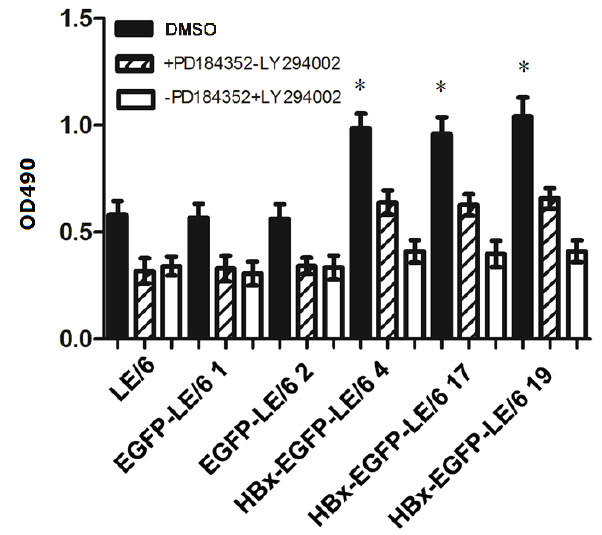
Figure 5. MTT assay of HBx-EGFP-LE/6, EGFP-LE/6, and LE/6 oval cell lines treated with PD184352 or LY294002. Six different cell lines, namely LE/6, EGFP1, EGFP2, HBx-EGFP4, HBx-EGFP17, and HBx-EGFP19, were exposed to PD184352 (5 μ M), LY294002 (25 μ M), or a vehicle control (DMSO) in media containing 10% FBS for 72 h. An MTT assay was performed and results showed that treatment with either PD184352 or LY294002 significantly inhibited HBx-induced oval cell proliferation. An asterisk * indicates p < 0.05 vs. vehicle control (DMSO). The data shown represent the mean ± SD of three independent